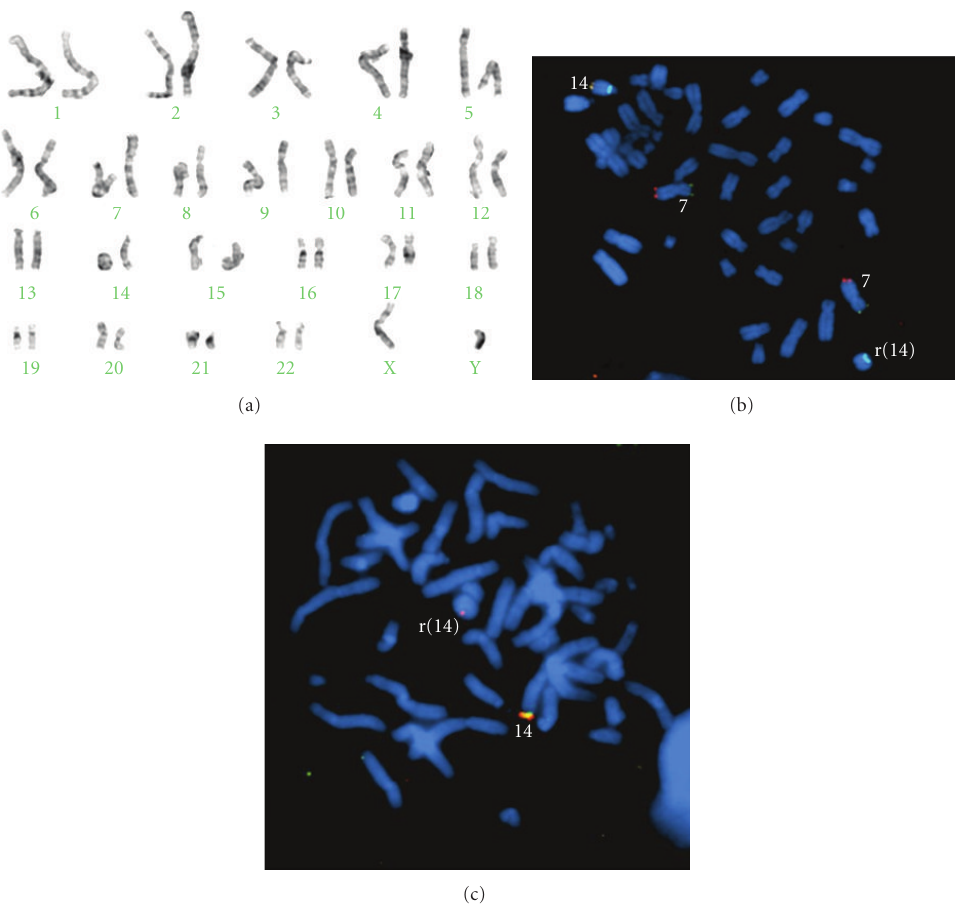
Figure 2: (a) Karyotype: 46,XY,r(14)(p11.2q32.33). (b) Hybridisation with ToTelVysion Mix 7 probes. Note the loss of signal corresponding to 14qter, maintaining the SpectrumAqua 14q control signal. (c) In situ hybridisation with LSI IGH Dual Color, Break Apart Rearrangement Probe. Note the two hybridisation signals in the normal chromosome 14 (red/green signal). Loss of LSI IGHV Probe (SpectrumGreen) was detected in chromosome